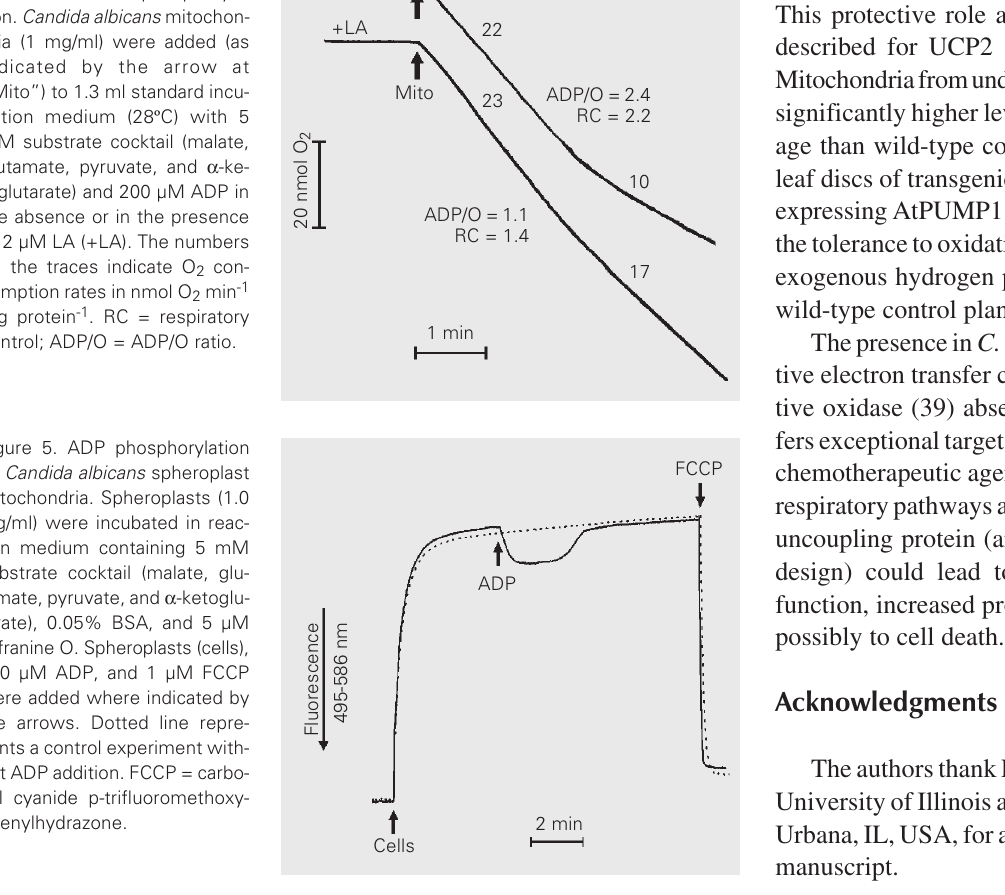
Figure 4. Effect of linoleic acid (LA) on oxidative phosphoryla- tion. Candida albicans mitochon- dria (1 mg/ml) were added (as indicated by the arrow at “Mito”) to 1.3 ml standard incu- bation medium (28 º C) with 5 mM substrate cocktail (malate, glutamate, pyruvate, and α -ke- toglutarate) and 200 µM ADP in the absence or in the presence of 2 µM LA (+LA). The numbers on the traces indicate O 2 con- sumption rates in nmol O 2 min -1 mg protein -1 . RC = respiratory control; ADP/O = ADP/O ratio.